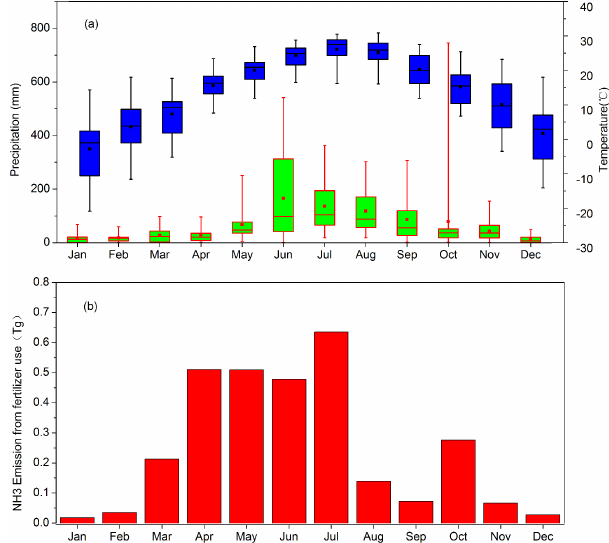
Figure 7. (a) The variation of monthly precipitation (green) and temperature (blue) in 31 provinces. In the box-and-whisker plots, the boxes and whiskers indicate the 100th (max), 75th, 50th (me- dian), 25th and 0th (min) percentiles, respectively. The point repre- sents the average value. (b) Monthly NH 3 emissions from N fertil- izer